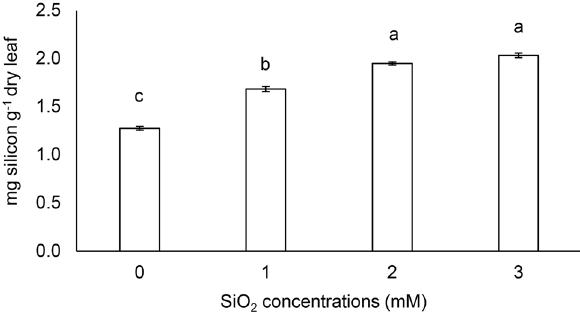
Figure 7. Silicon content in leaves from Passiflora incarnata L. subjected to SiO 2 variations. Values corresponding to the averages ± SE.